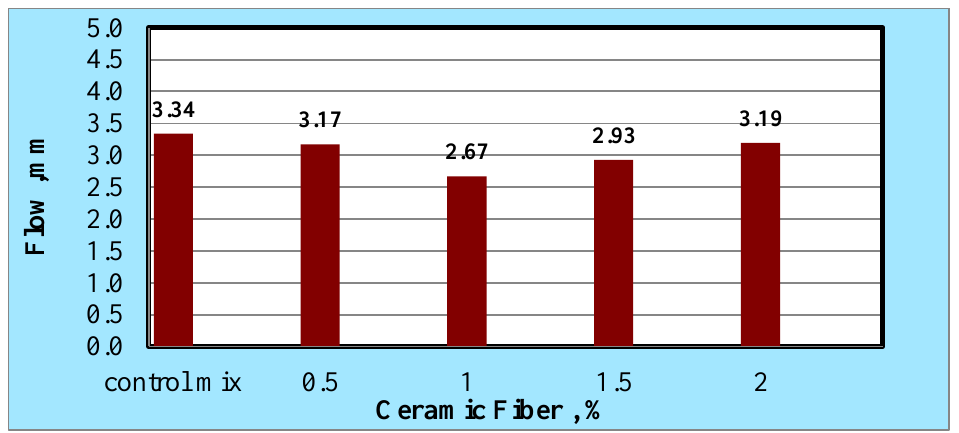
Fig. 2. Effect of Ceramic Fiber on Marshall Flow of Asphalt Mixture.